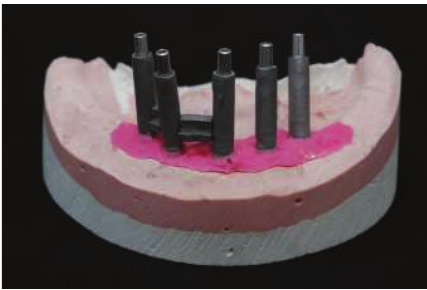
Figure 2: Multifunctional guide.